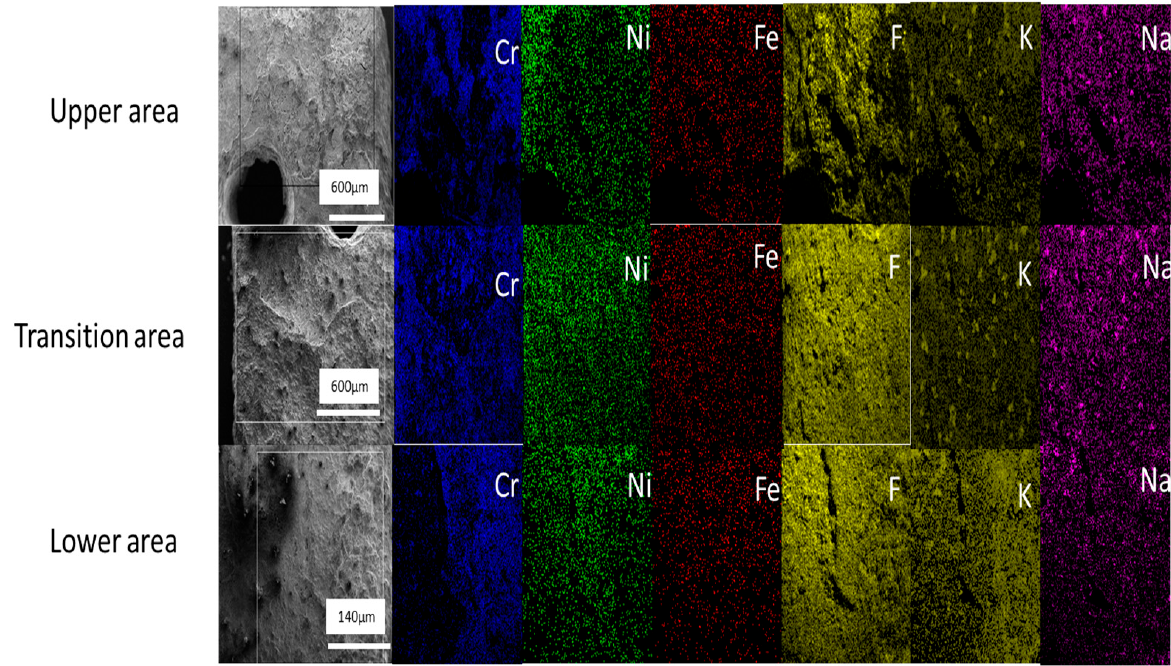
Figure 9. Surface mapping of Hastelloy ® G35 ® with concentration of different elements on the sur- face.